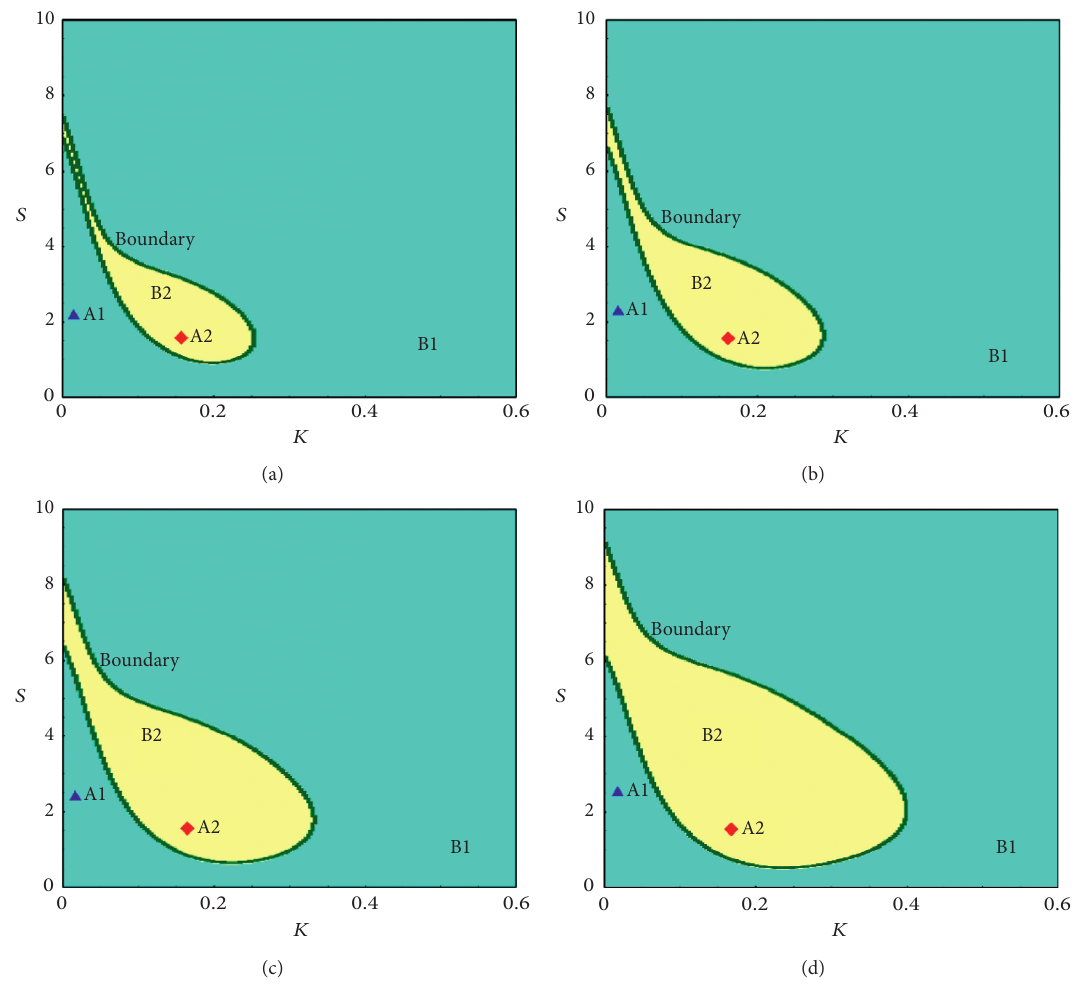
Figure 6: The global dynamic character of system (4): b